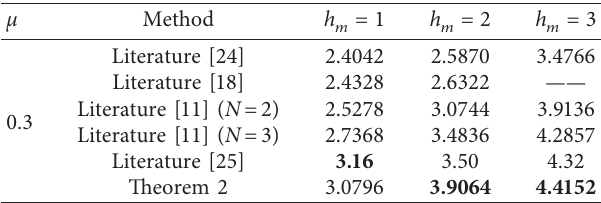
Table 3: In Example 2, MADB is simulated to be obtained for different h m and different methods.